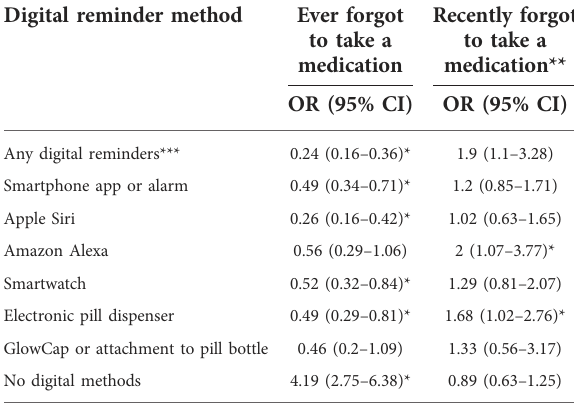
TABLE 4 Bivariate associations between Use of digital reminders and self-reported medication adherence. Digital reminder